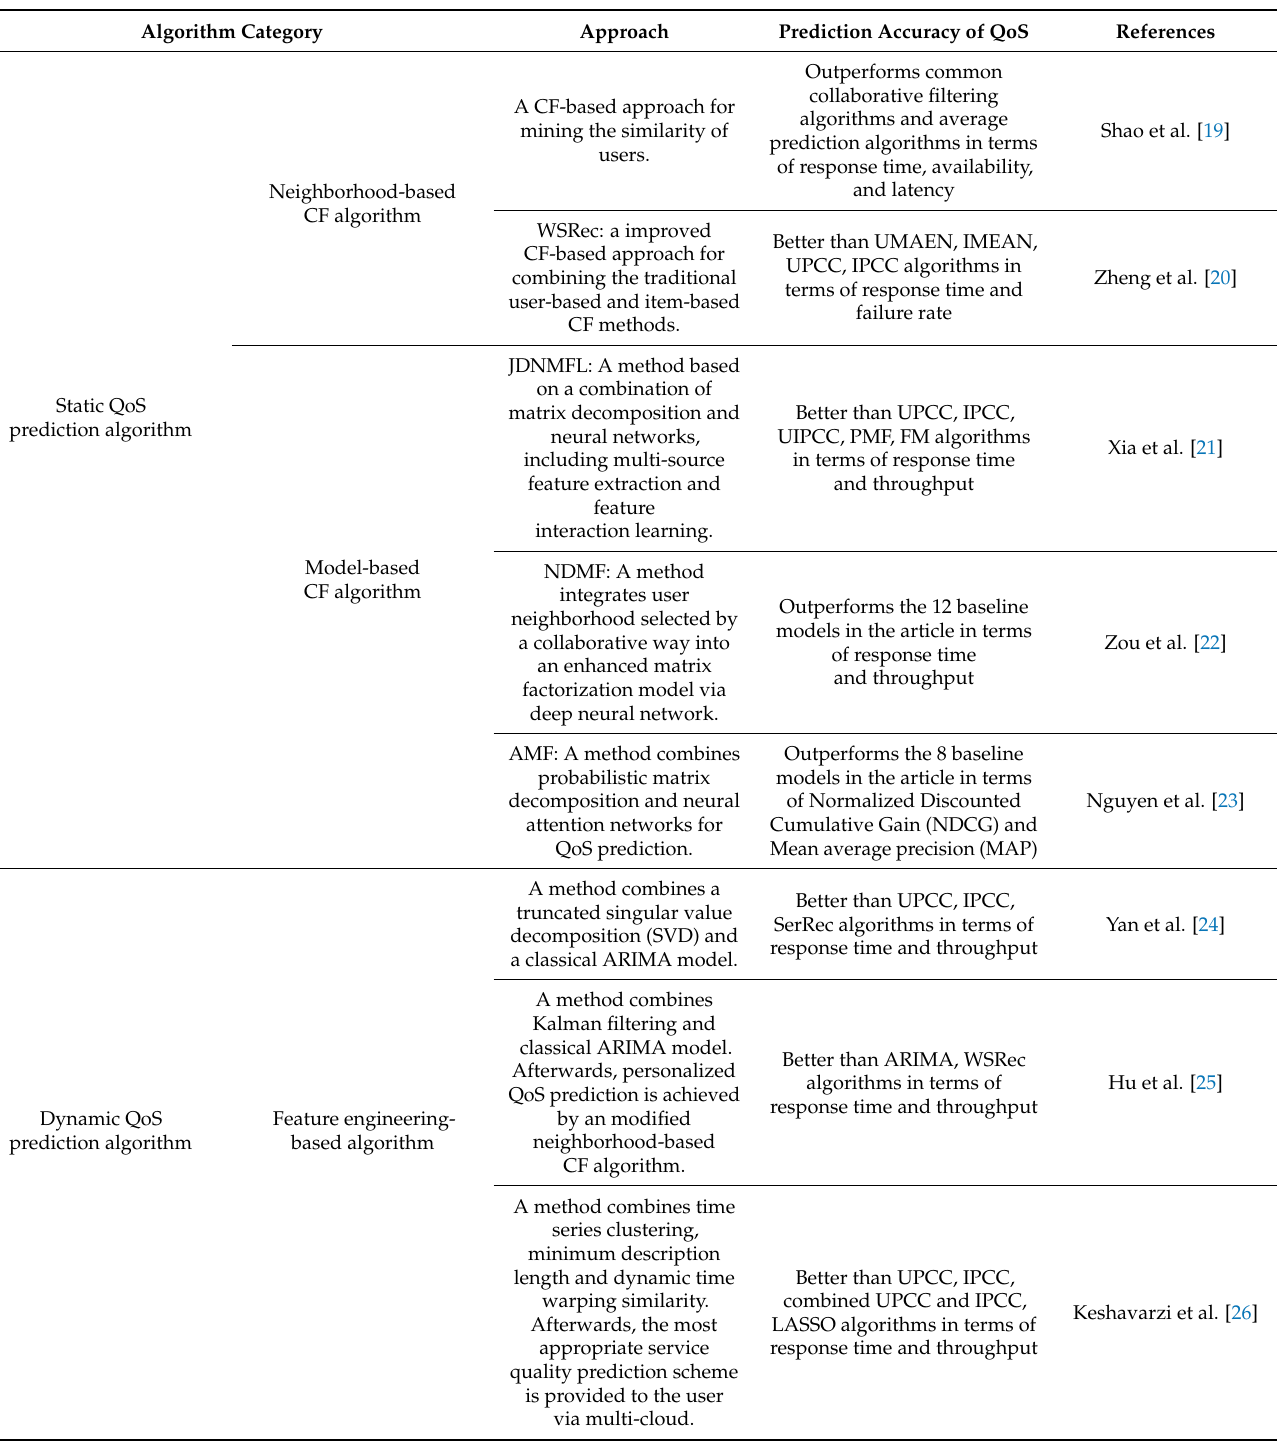
Table 1. Comparison of methods and results of research in related